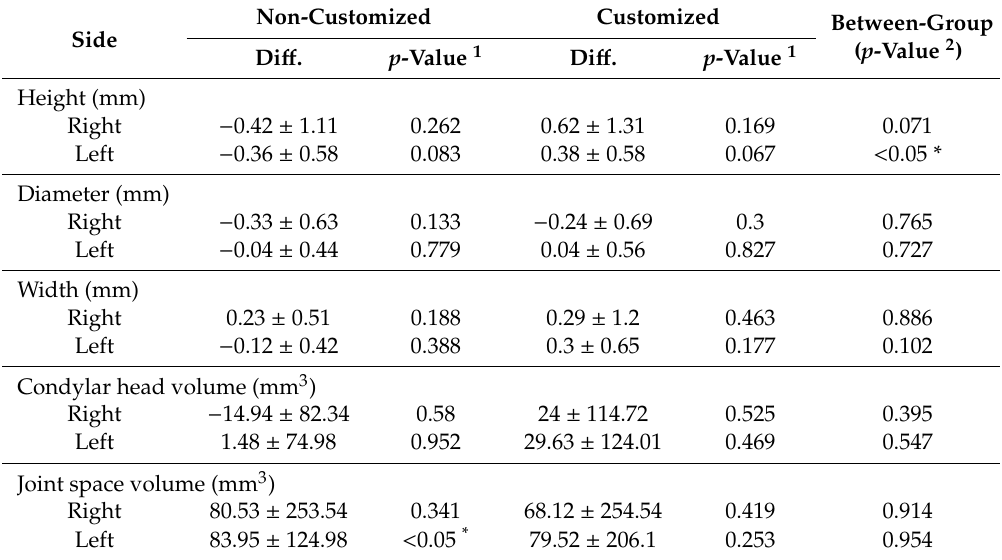
Table 5. Comparison of the condylar morphologic changes between the two groups (T2 vs. T0). Non-Customized Customized Between-Group Side